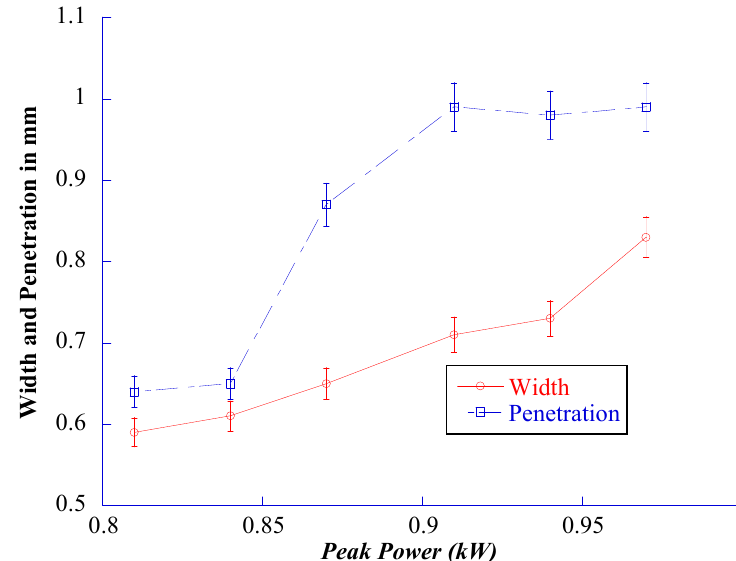
Figure 2. Influence of laser peak power on the weld width and penetration.